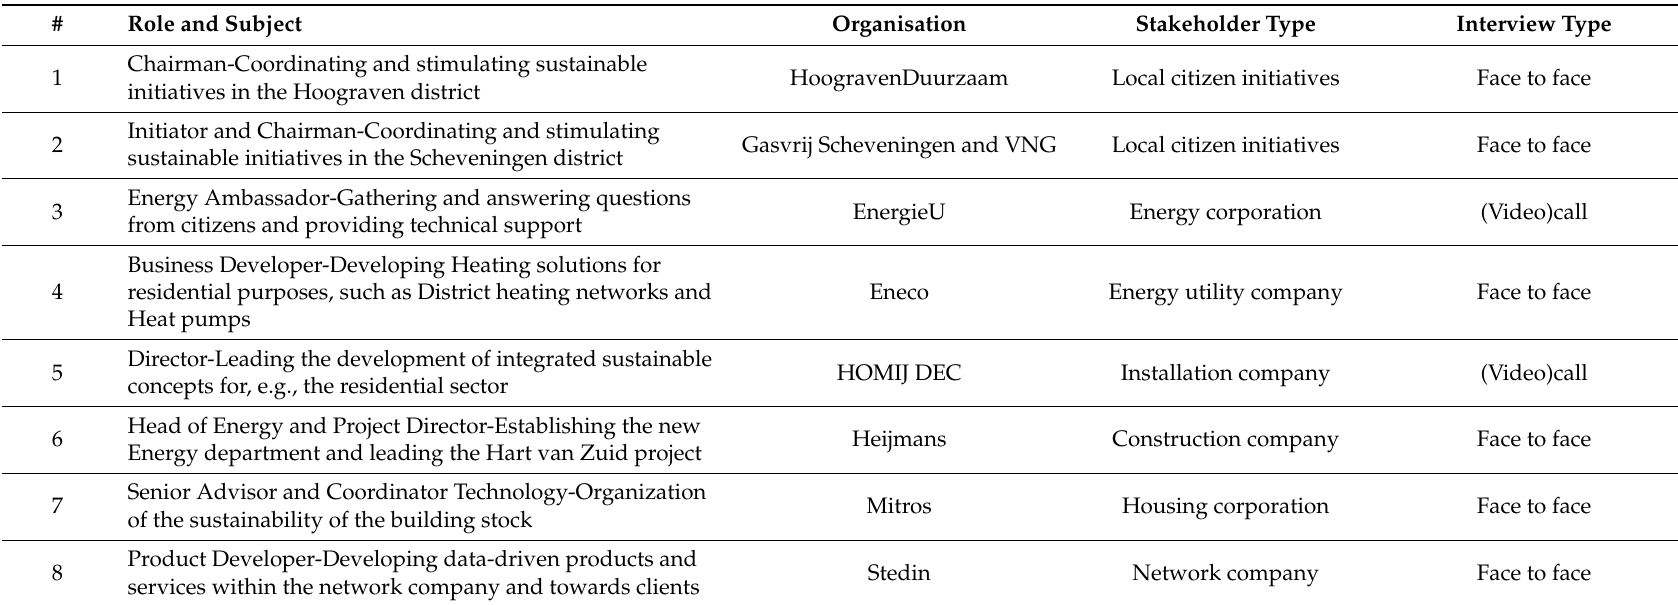
Table A2. Interviews for the problem analysis and ecosystem